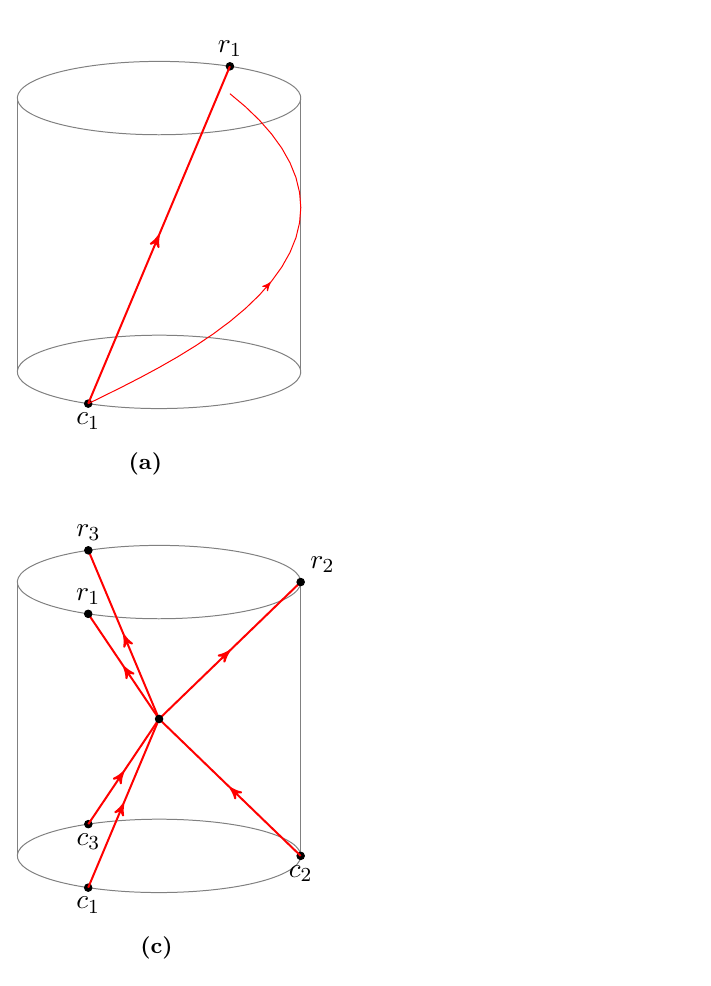
Figure 1. (a) With one input point and one output point the bulk causal structure is fixed by the boundary causal structure: the Gao-Wald theorem [1] dictates that bulk light rays are never faster than boundary light rays. (b) With two input and two output points the bulk causal structure may be stronger than the boundary one. Shown here is a case where the four points scatter causally in the bulk but not in the boundary. An essential part of reconciling this discrepancy is entanglement in the boundary state, as discussed in [2–4]. (c, d) For three or more input and output points there are many possible bulk causal structures, which again may feature scattering regions not appearing in the boundary. In this article we study how these richer causal structures are supported through boundary